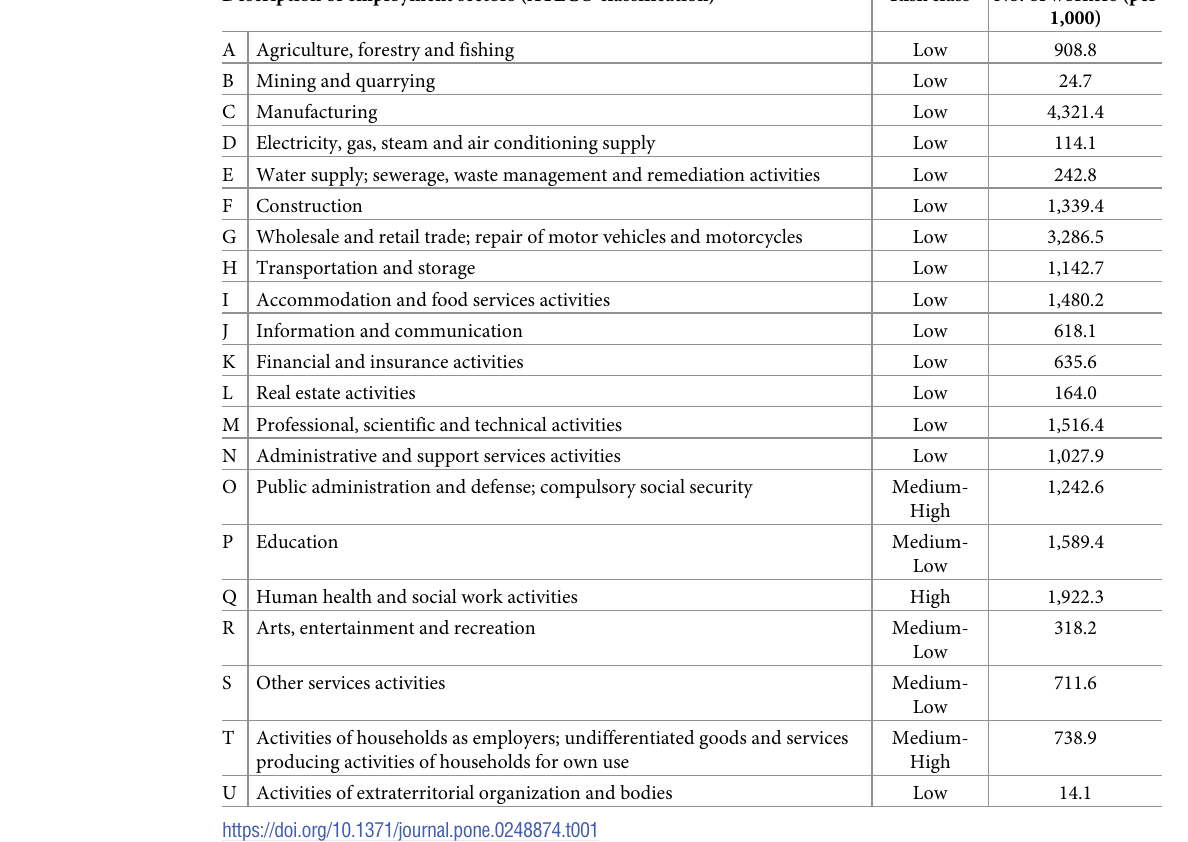
Table 1. Risk class and working population by employment sector. Description of employment sectors (ATECO